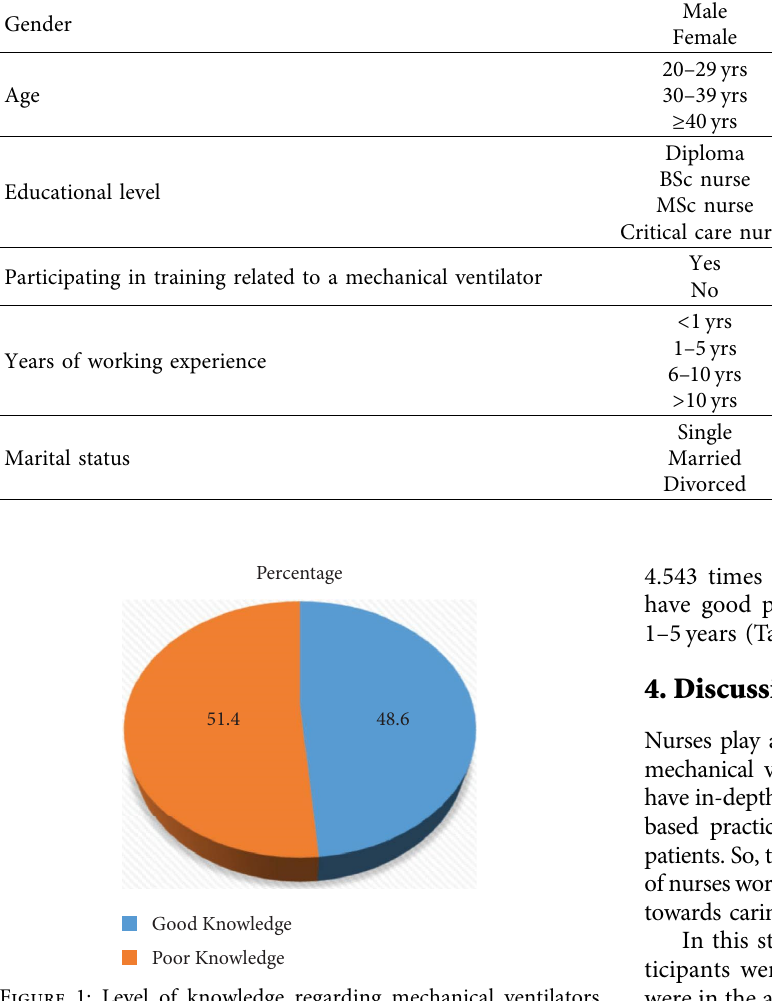
Table 1: Sociodemographic characteristics of nurses working in the ICU of selected hospitals in Addis Ababa, 2021. Variables